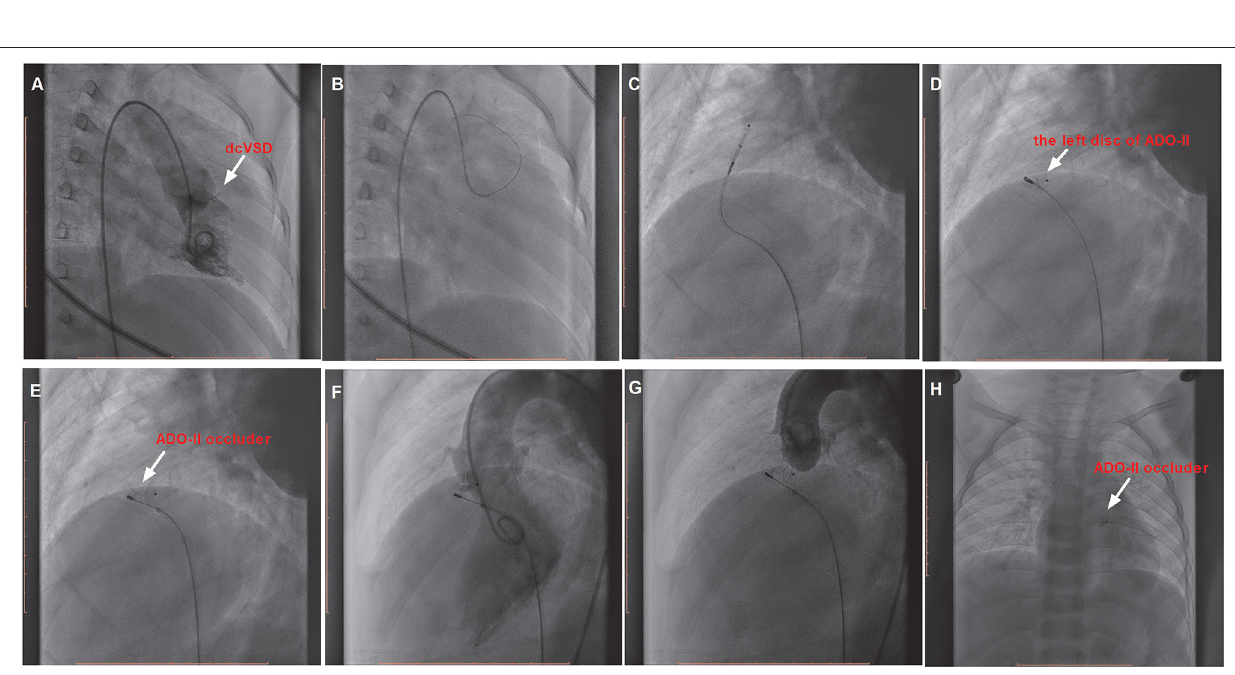
FIGURE 3 | The procedure of transcatheter closure of the dcVSD using the ADO-II device via the antegrade approach. (A) Confirms the location of the dcVSD (arrow) with left-to-right shunting on left ventriculography before the procedure. (B–E) Show the whole processes of the transcatheter technique. (F) shows the operational success and no significant RS by left ventriculography, and (G) Shows no AR after device implantation by aortography before releasing the occluder. (H) Demonstrates the good position and configuration of the released occluder under X-ray fluoroscopy. dcVSD, doubly committed subarterial ventricular septal defect; AR, aortic regurgitation; RS, residual